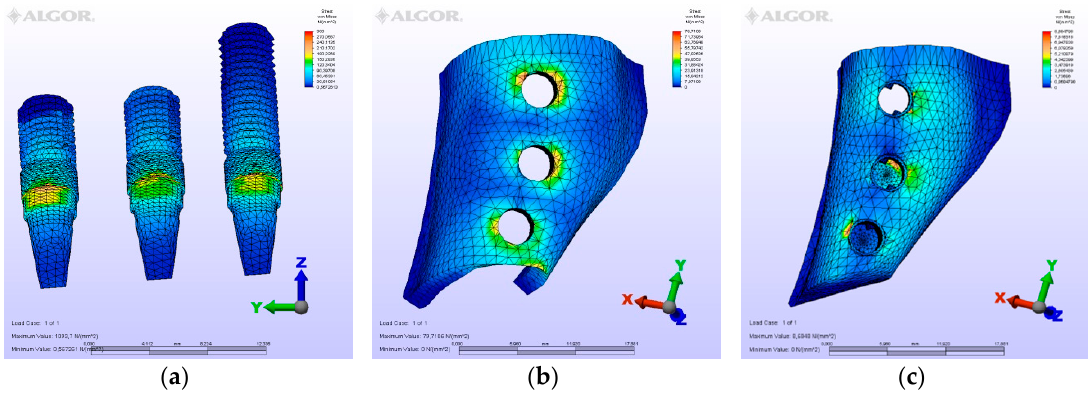
Figure 8. Model M3, axial loading. ( a ) the maximum von Mises stresses around implants; ( b ) maximum principle stress in cortical bone; ( c ) maximum principle stress in cancellous bone.